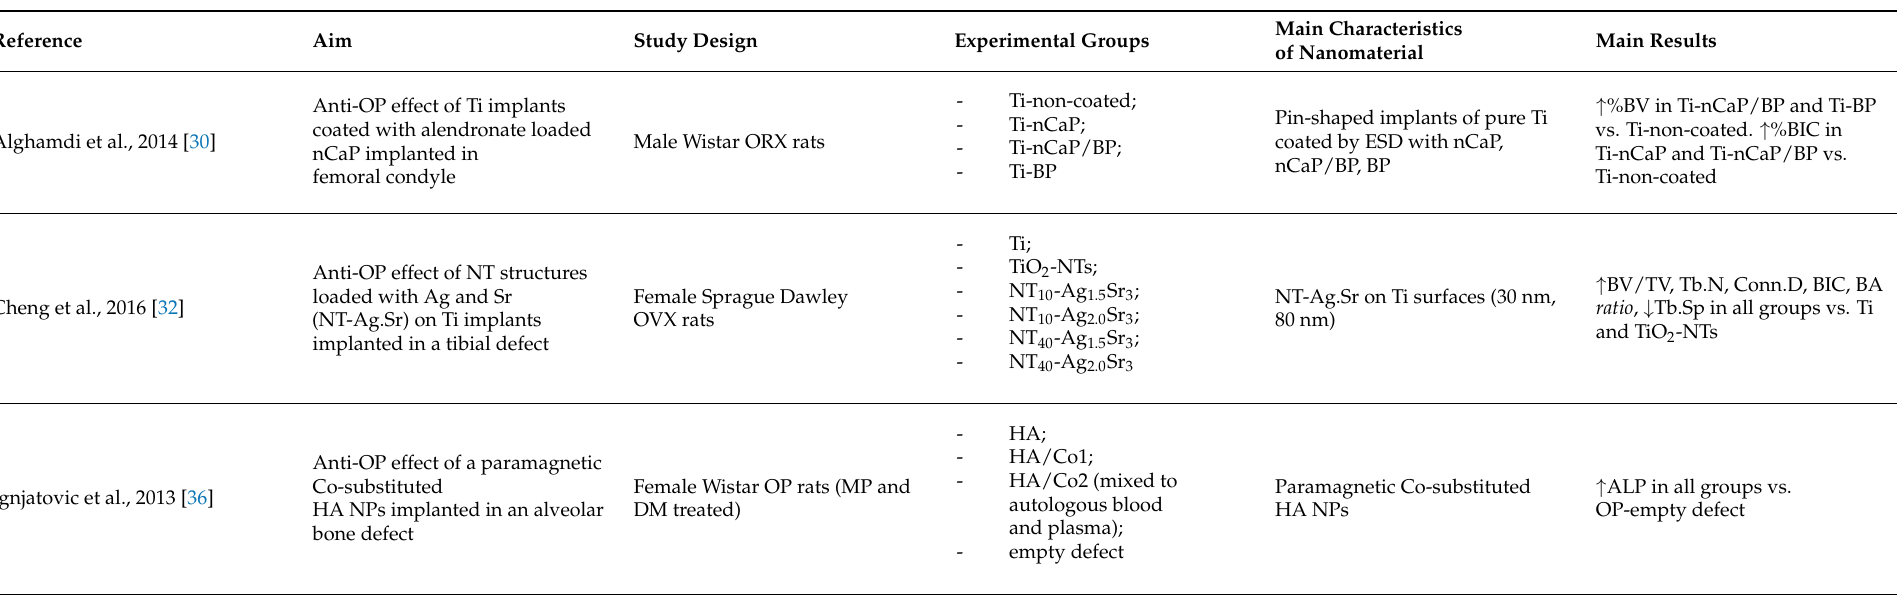
Table 2. Preclinical in vivo studies where the implant-based delivery approach was used to deliver drugs through nano-based materials in OP